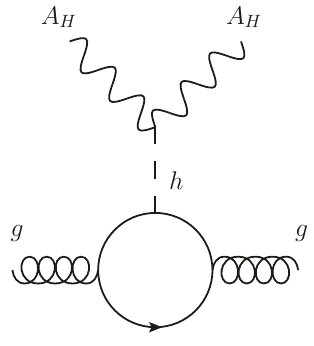
Figure 16 . Relevant direct detection